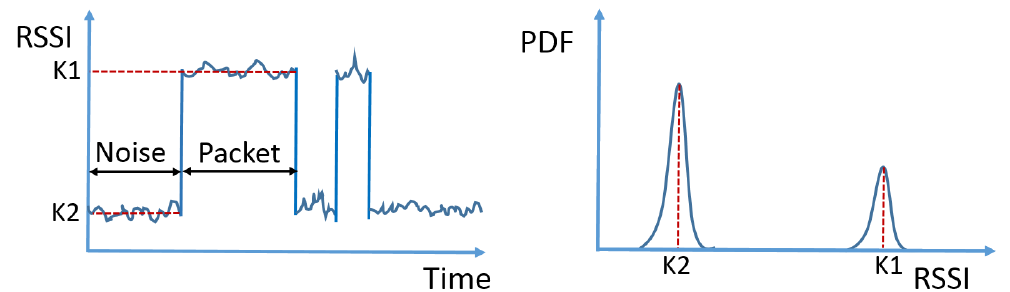
Figure 1. An example RSSI trace of a discontinuously-transmitted signal ( left ) and the corresponding PDF ( right ).